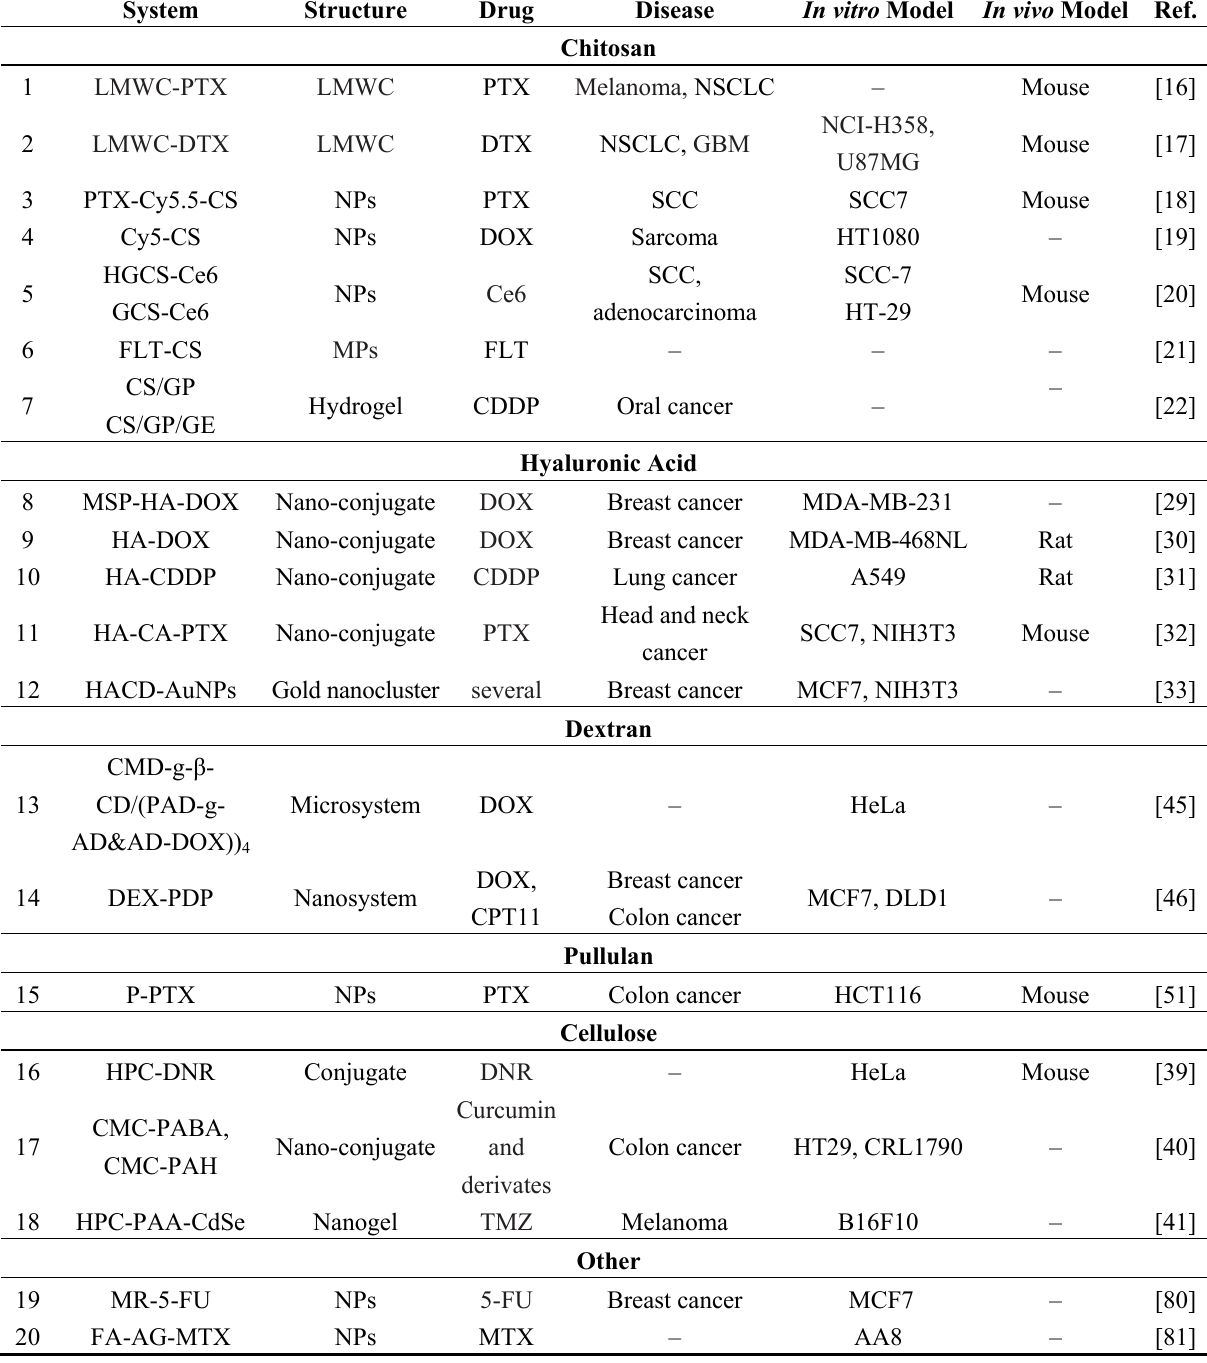
Table 2. Polysaccharide-based delivery of chemotherapy